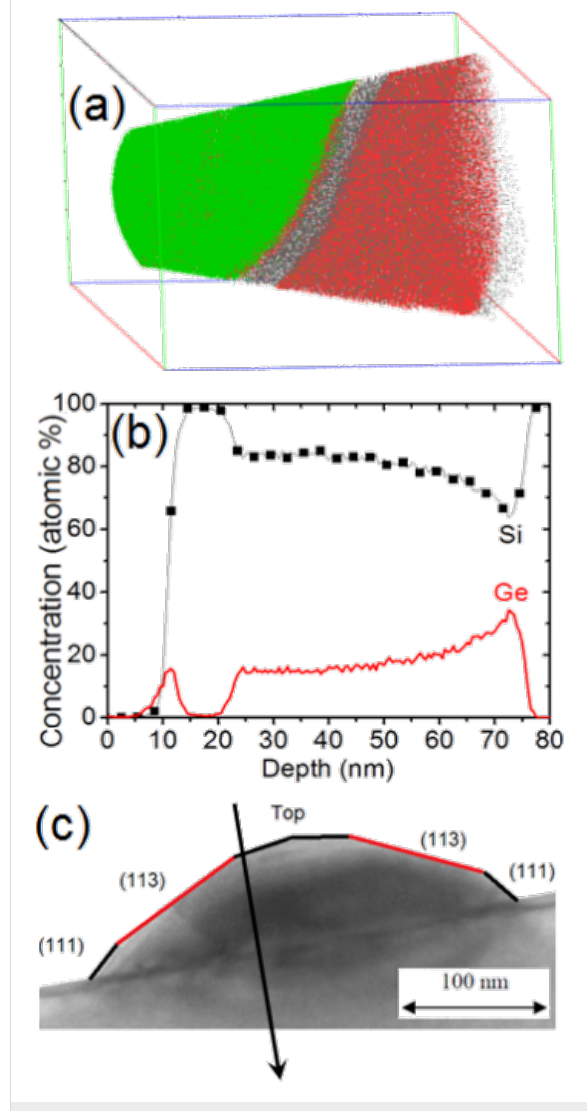
Figure 9: (a) APT volume (90 × 90 × 130 nm 3 ) and (b) Si and Ge 1D concentration profiles measured in (a). Figure 9c indicates the direction in which the concentration profiles were measured in the